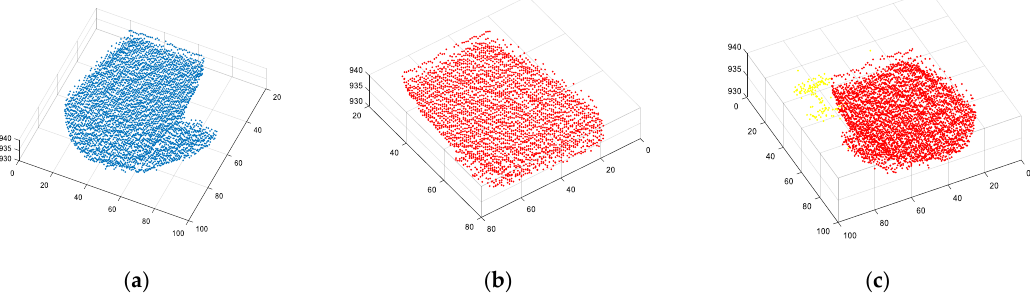
Figure 5. The segmentation effect of the traditional segmentation method on experimental data. ( a ) Segmentation algorithm based on edge detection; ( b ) segmentation algorithm based on region growth; ( c ) segmentation algorithm based on Euclidean clustering.